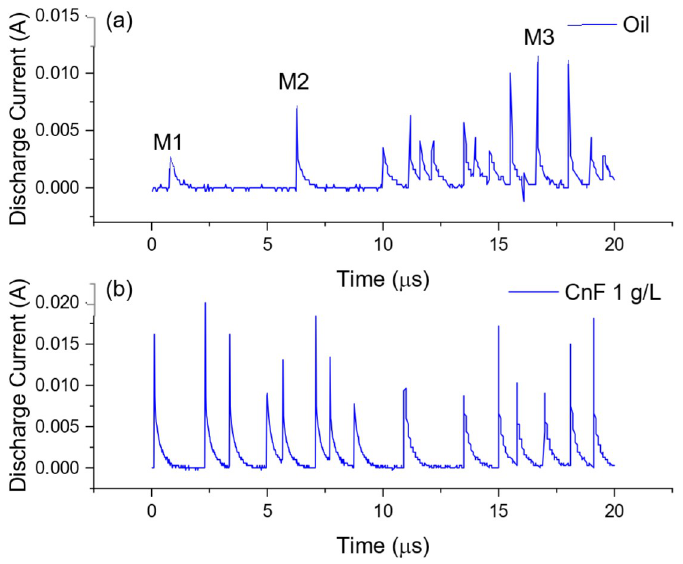
Figure 10. Current waveforms during EDM using ( a ) oil and ( b ) carbon nanofiber mixed EDM (1 g/L) at 110